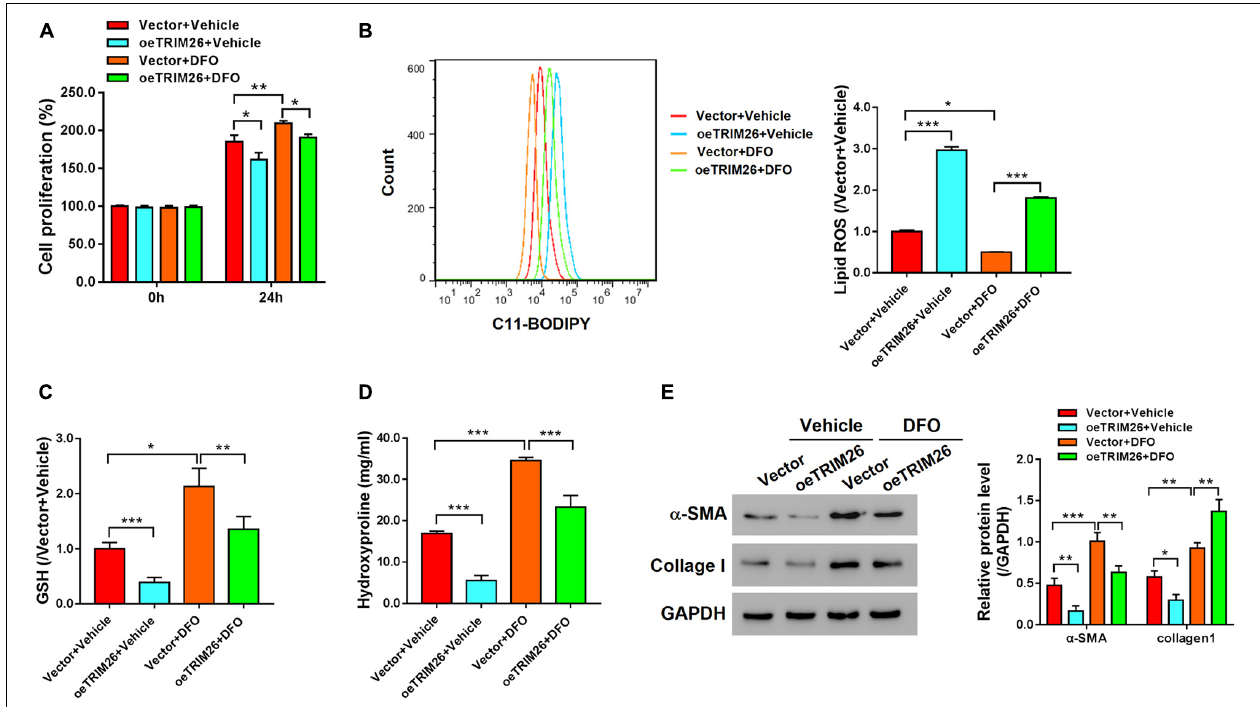
FIGURE 3 | Effect of TRIM26 overexpression on deferoxamine (DFO)-inhibited fibrosis. LX-2 cells were treated with 100 µ M DFO or Vehicle after 24 h of Vector/oe TRIM26 transfection. (A) Cell proliferation. (B) Lipid peroxidation level. (C) Glutathione content. (D) Hydroxyproline content. (E) Protein expressions of α -SMA and collagen I. * P < 0.05; ** P < 0.01; *** P < 0.001.